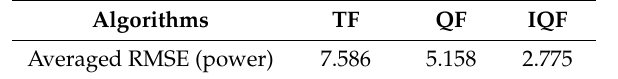
Table 6. Averaged RMSE of the return waveforms using the Aquarius dataset.